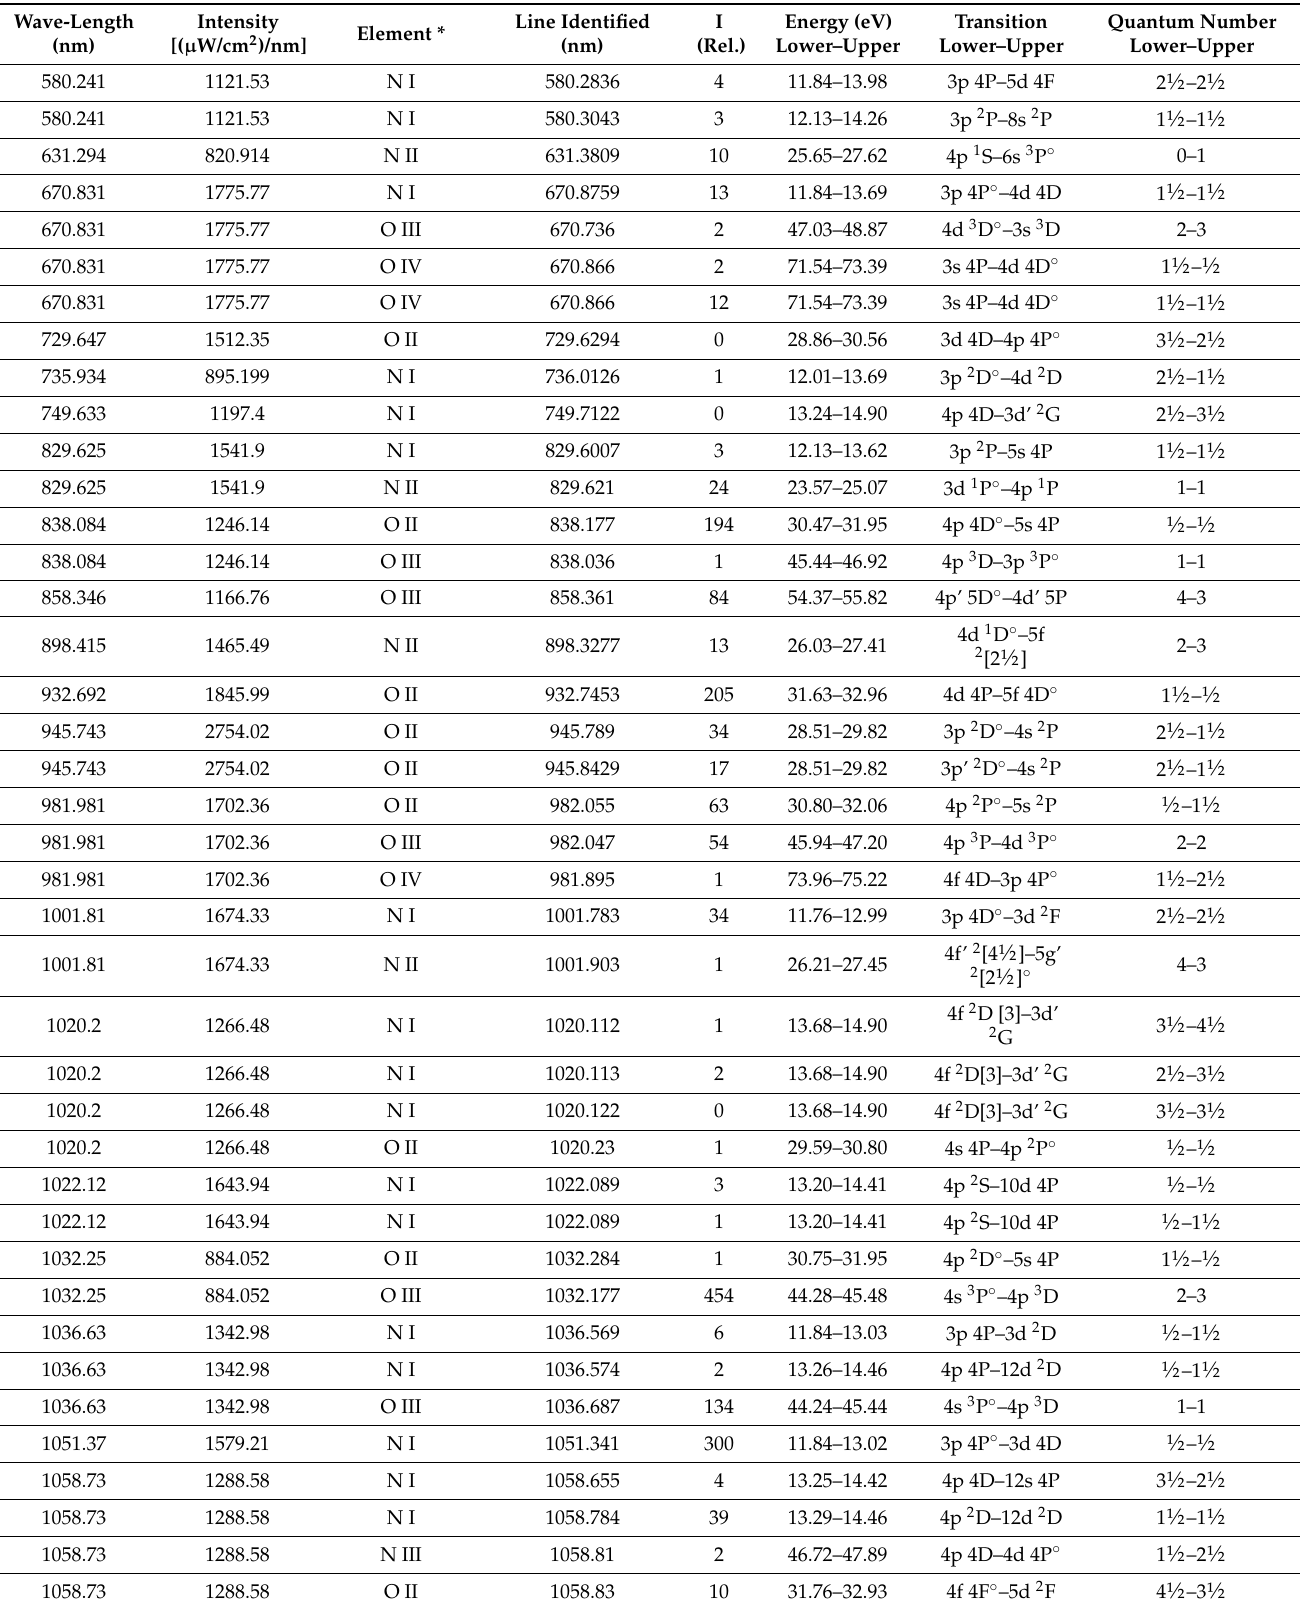
Figure 3. Intensity vs. wavelength for oxygen and nitrogen species generated by plasma at ( a ) 0 s and ( b ) 15 s with flow rate 7 SLPM. Table 1. Reactive species identified via OES at 7 slpm at 0 s, with 30 RNS and 18 ROS.